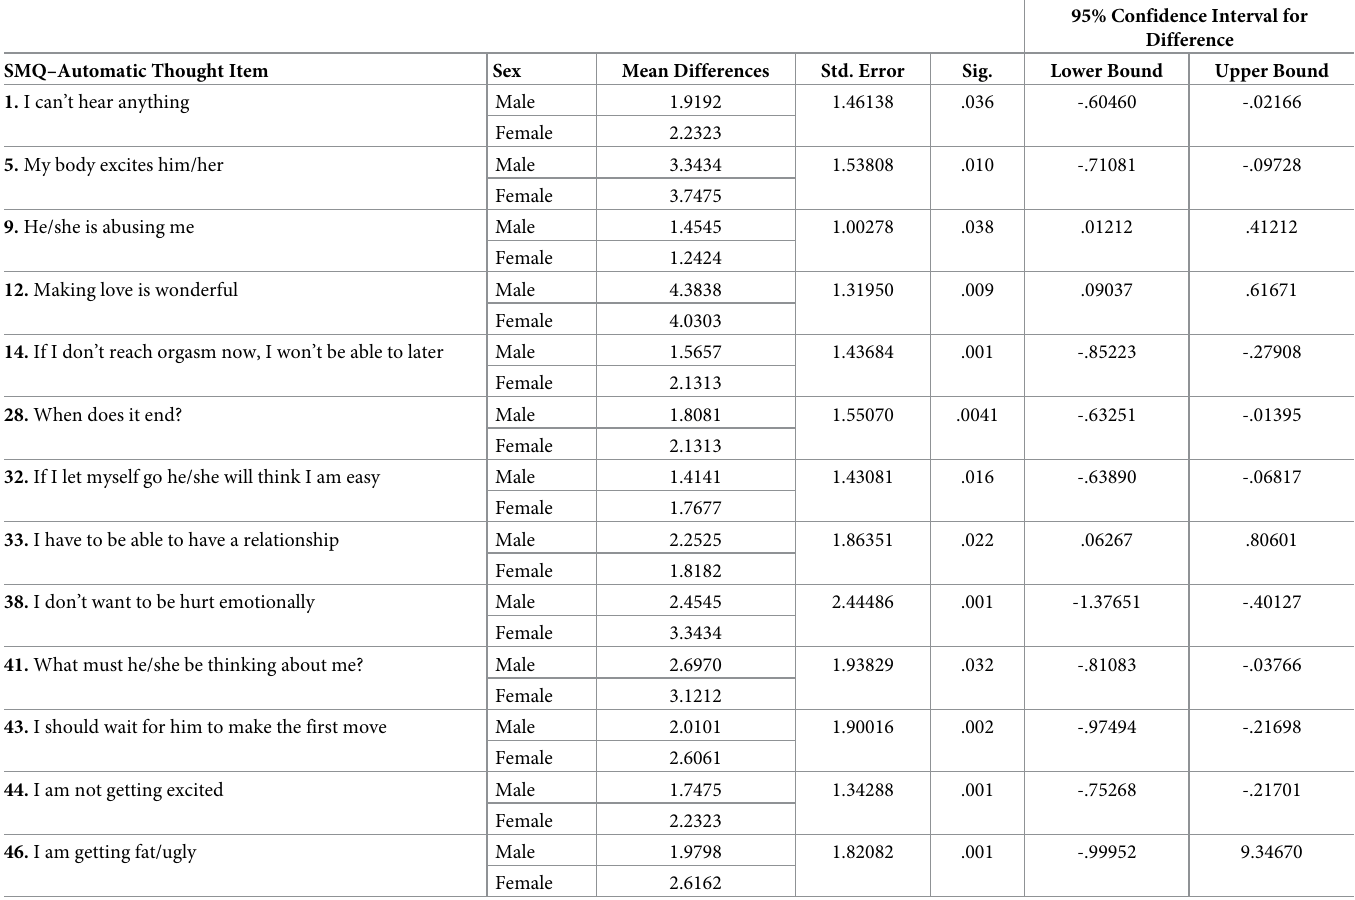
Table 1. t-test computed to compare the effect of sex (male/female) on the values of the AT scale at p < .05